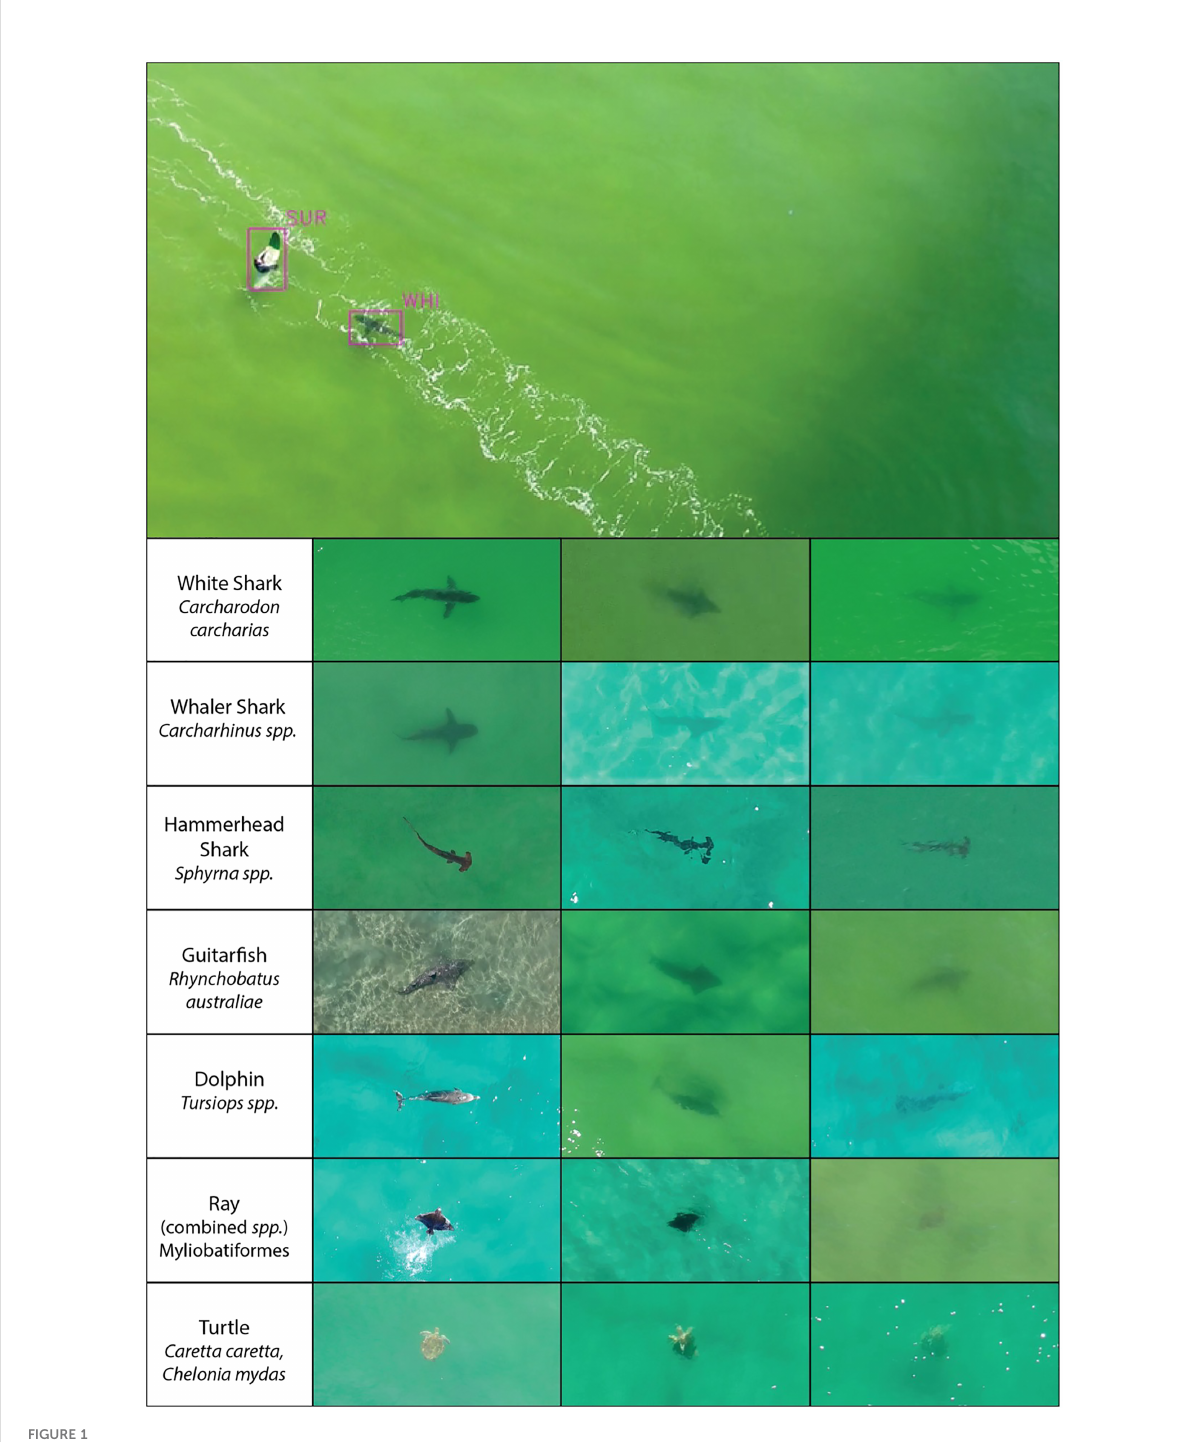
FIGURE 1 Examples of image data used in this work. Top Image: Representative view from the drone at a height of ~ 60m (image has been cropped from the full-frame view). Here we see a close interaction between a surfer and a white shark C. carcharias. Pink rectangles illustrate the closely- fi tted bounding boxes used to train the object detection model. Lower Images: Each row presents high-, medium- and low-quality images, respectively, of the animals investigated in this study. The quality assessment was done manually by experienced observers and depends on the depth of the animal, water turbidity, sun glitter and degree of distortion at the